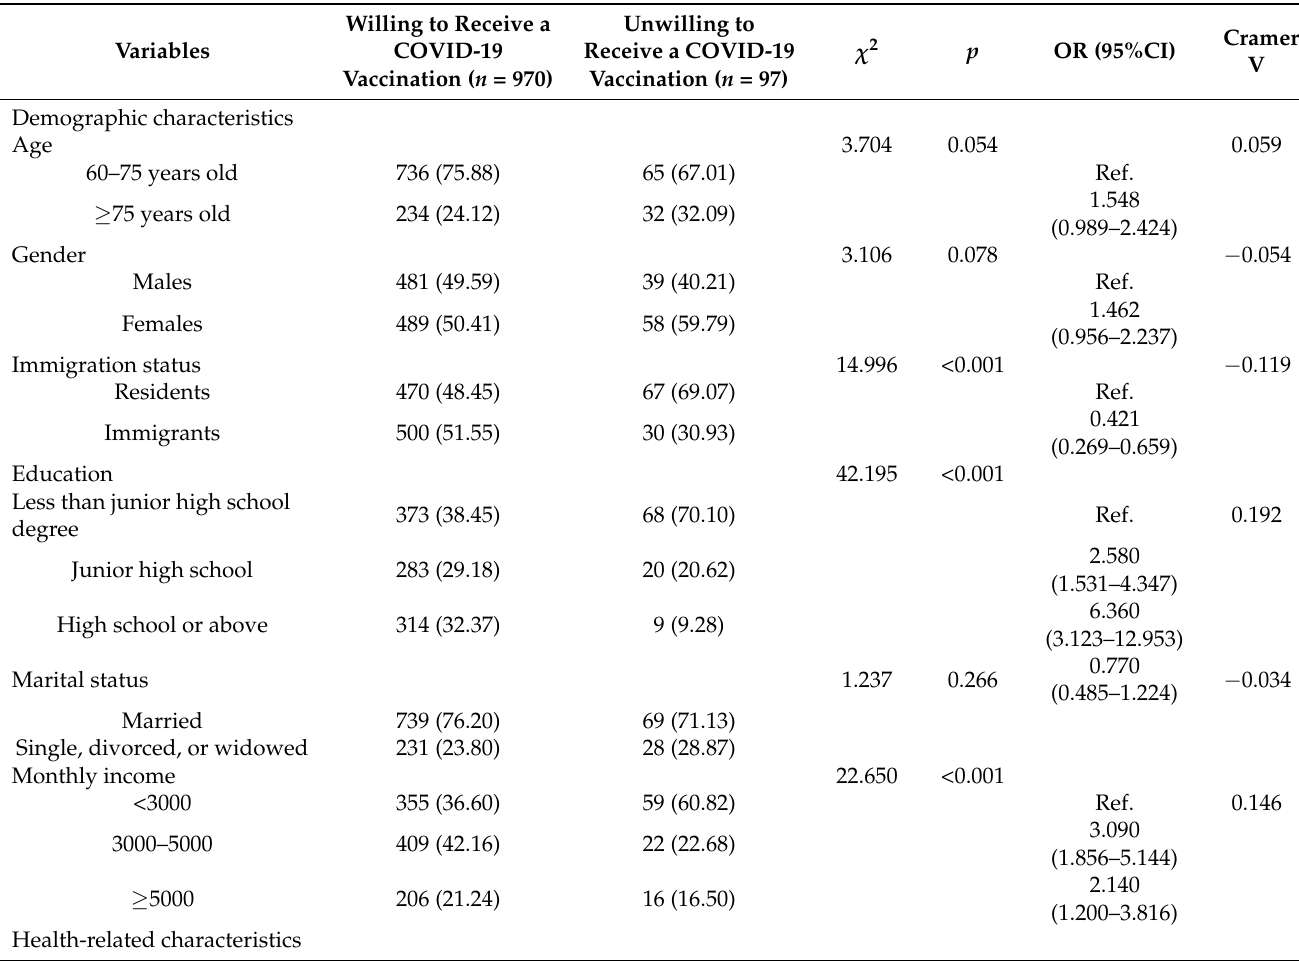
Table 2. Differences in willingness to receive a COVID-19 vaccination between different demographic characteristic